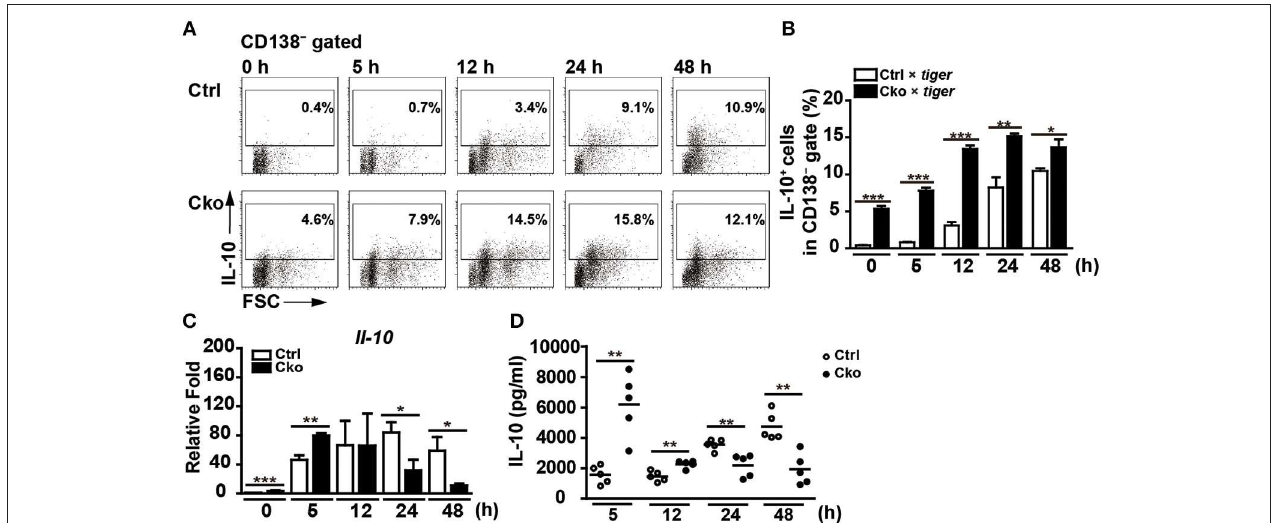
FIGURE 6 | Blimp-1-deficient B10 cells stimulated in culture showed disturbed IL-10 production. (A,B) CD19 + CD1d hi CD5 + B10 cells were sorted from Ctrl × tiger and Cko × tiger mice and then stimulated with LPS (10 µ g/ml) for the indicated lengths of time. FACS analysis showing the frequency of IL-10 + (GFP + ) cells in the CD138 − gate (A) . Statistical results from two independent biological repeats of the experiment described in (A) are shown (B) . (C,D) The Il-10 mRNA levels in stimulated B10 cells (C) and IL-10 secretion by stimulated B10 cells (D) from the culture described in (A) were detected by RT-qPCR and ELISA, respectively ( n = 3–8 mice per group). Data were analyzed using an unpaired Student’s t -test and are the mean ± SEM. * p < 0.05, ** p < 0.01, and *** p <